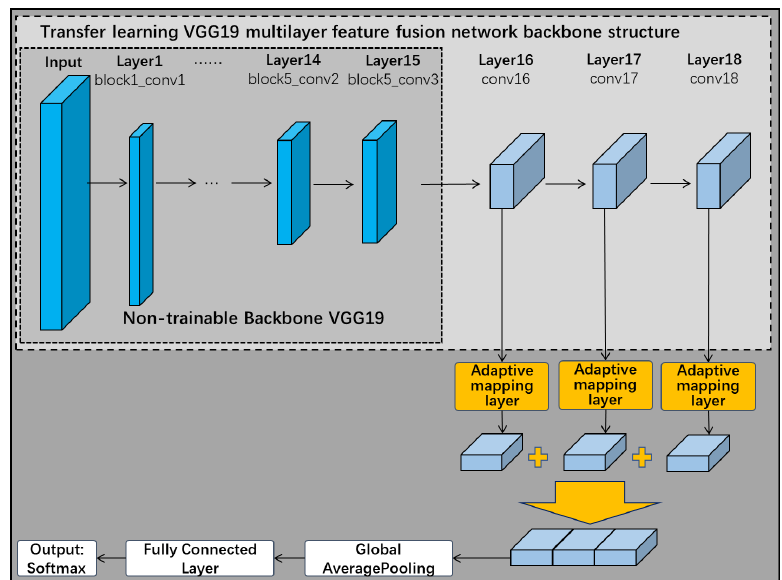
Figure 18. VGG19 multilayer feature fusion network for multi-source data